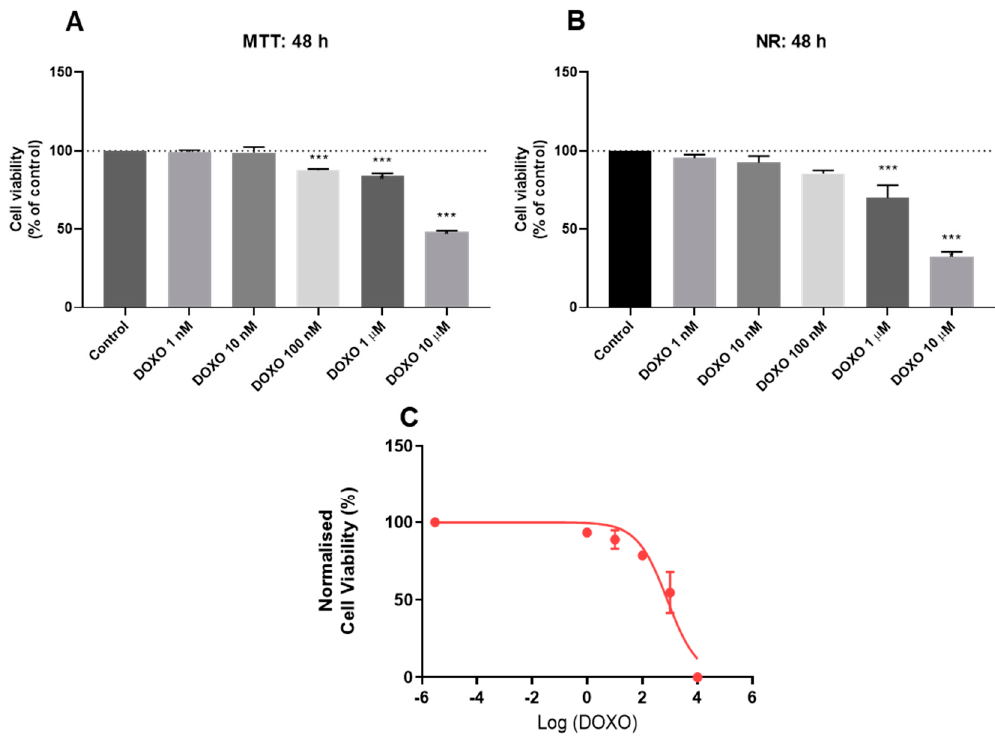
Figure 5. Effects of DOXO on the viability of HT-29 colon cancer cells determined by ( A ) MTT and ( B ) NR assays. Based on the results of the NR assay, a dose-response curve was calculated ( C ). Cells were treated with increasing concentrations of DOXO for 48 h. The results are shown as the percentage of the control and are expressed as the mean ± SEM of three independent experiments ( n = 3). *** Statistically significant vs. the control at p < 0.001. **** Statistically significant vs. the control at p < 0.0001.